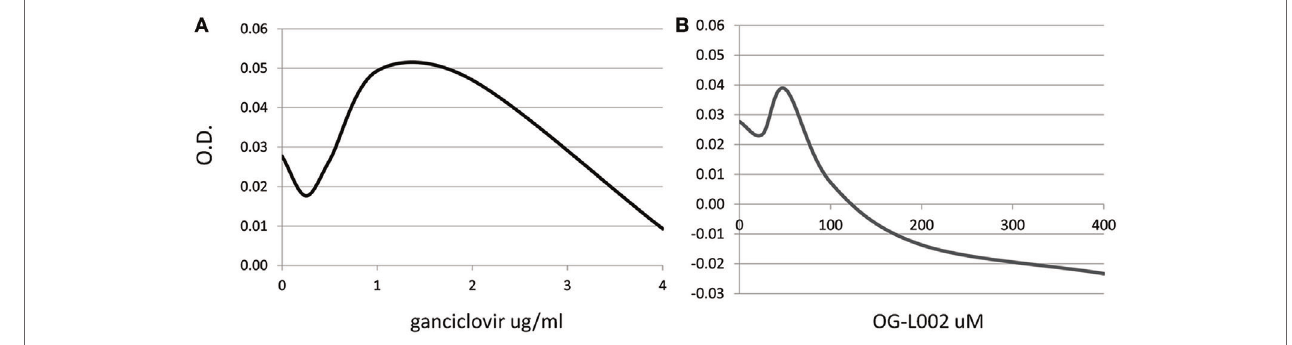
FigUre 1 | Dose-dependent cytotoxic effect of treatment. Cell viability of equine leukocytes was tested after 24 h of treatment with different concentrations of ganciclovir (a) or OG-L002 (B) using the MTT assay. Results indicate best-fit curve of mean values obtained from triplicate experiments at 540 nm optical density